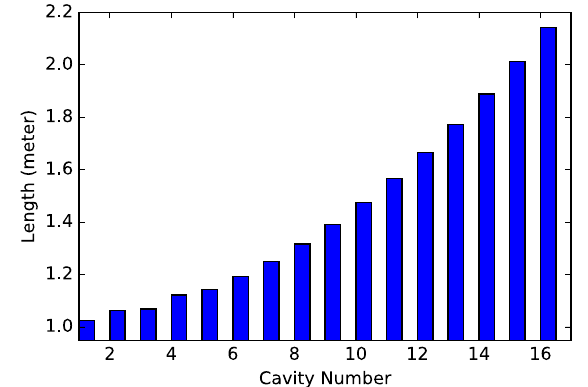
FIG. 3. Separation length from a cavity entrance to the next cavity